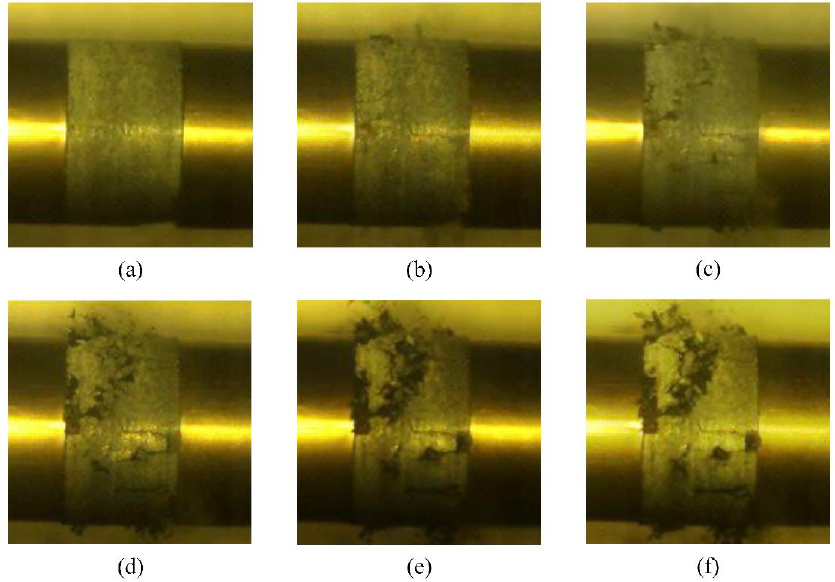
Figure 11. Failure process of a 50 mm diameter specimen. ( a ) about 308 μ s, ( b ) about 498 μ s, ( c ) about 698 µ s. ( d ) about 898 µ s, ( e ) about 1098 µ s, ( f ) about 1298 µ s.